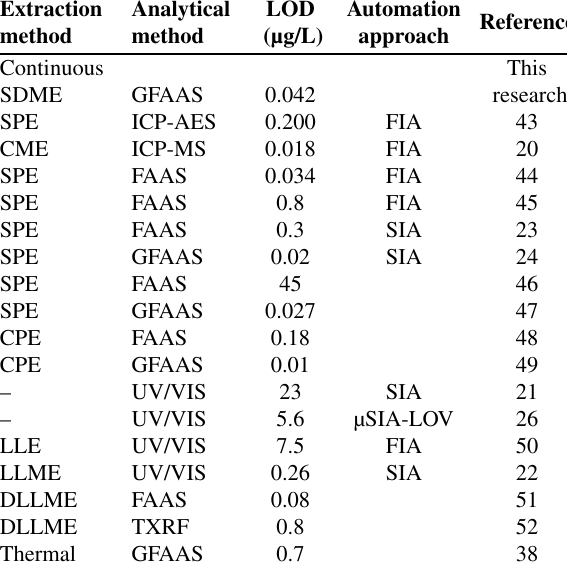
Table 5. Comparison of Cr(VI) determination methods for water samples